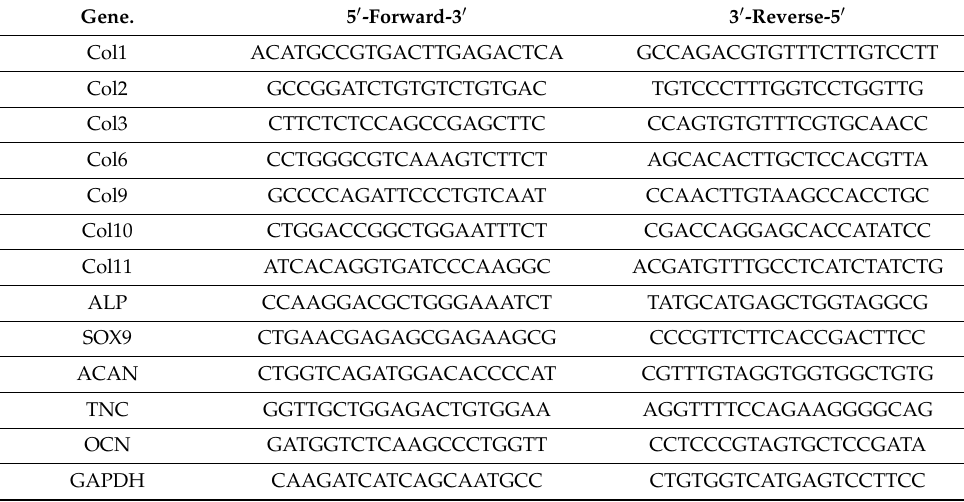
Table 1. RT-qPCR primers used in the